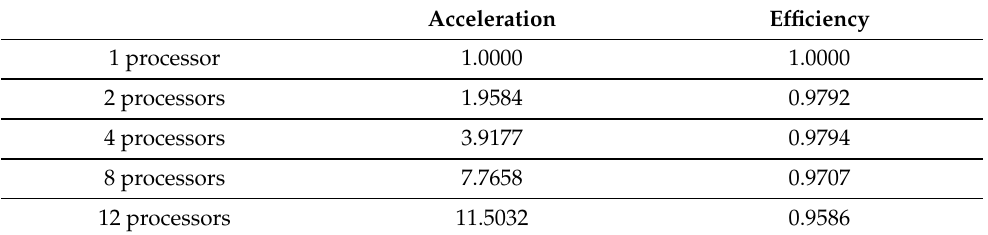
Table 1. The acceleration and efficiency of the parallel algorithm. Acceleration